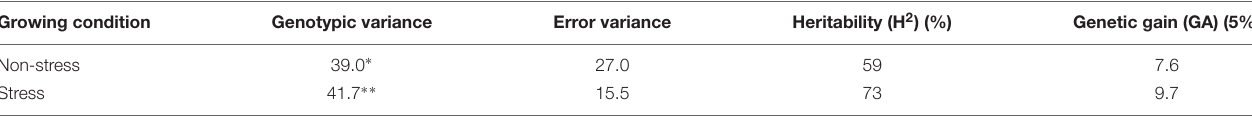
TABLE 2 | Variance, heritability and genetic gain of root length among 91 diverse wheat genotypes grown under non-stress and stress conditions. Growing